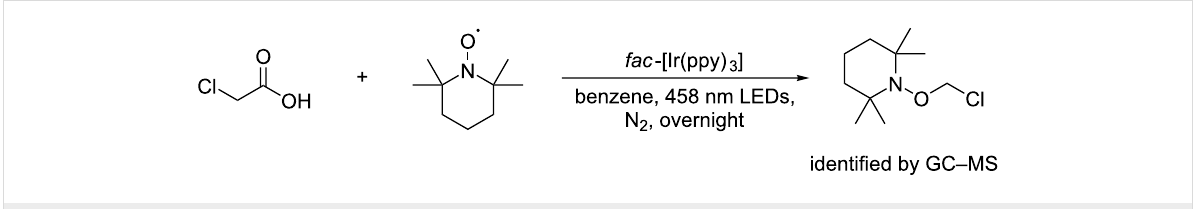
Scheme 7: The photoredox formation of